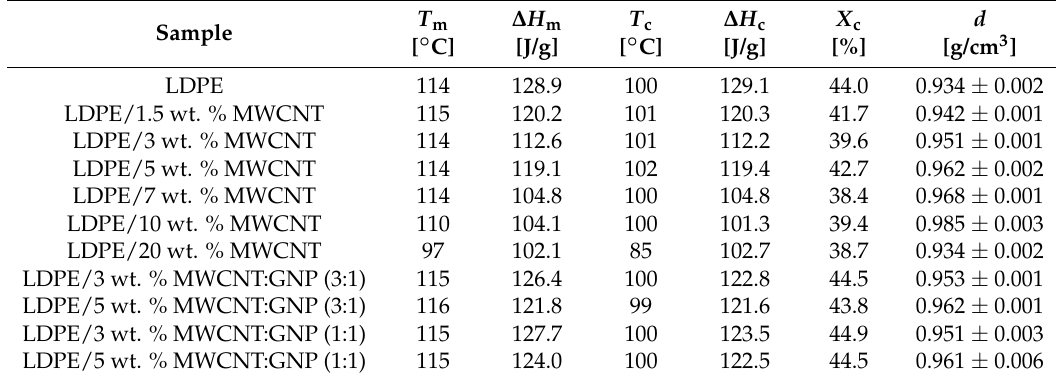
Figure 5. DSC thermograms for LDPE/MWCNT + GNP hybrid nanocomposites recorded during cooling ( a ) and second heating ( b ). Table 2. Phase transition temperatures and corresponding enthalpies of melting and crystallization, degree of crystallinity and hydrostatic density of LDPE-based